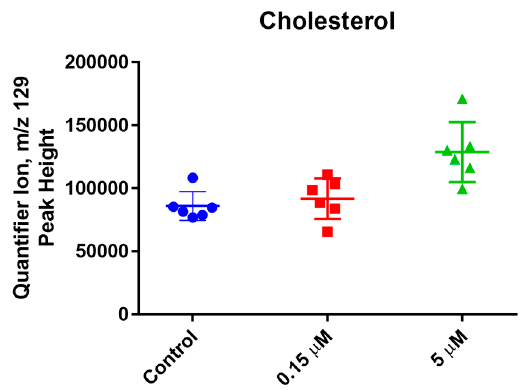
Figure 2. Levels of cholesterol in parasite treated with bauerenol ( 2 ). The levels of cholesterol in the parasite was significantly increased after 4-h exposure to 5 µM of 2 .